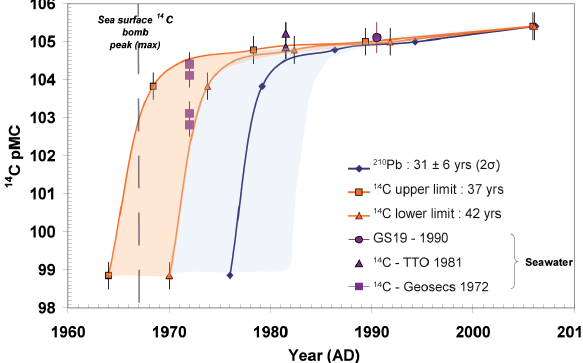
Fig. 7. ln-transformation of 210 Pb excess relative to the num- ber of polyps from the top of the Madrepora oculata specimen. The slope of this linear regression revealed a linear growth rate of 2.58 ± 0.19polypyr − 1 .